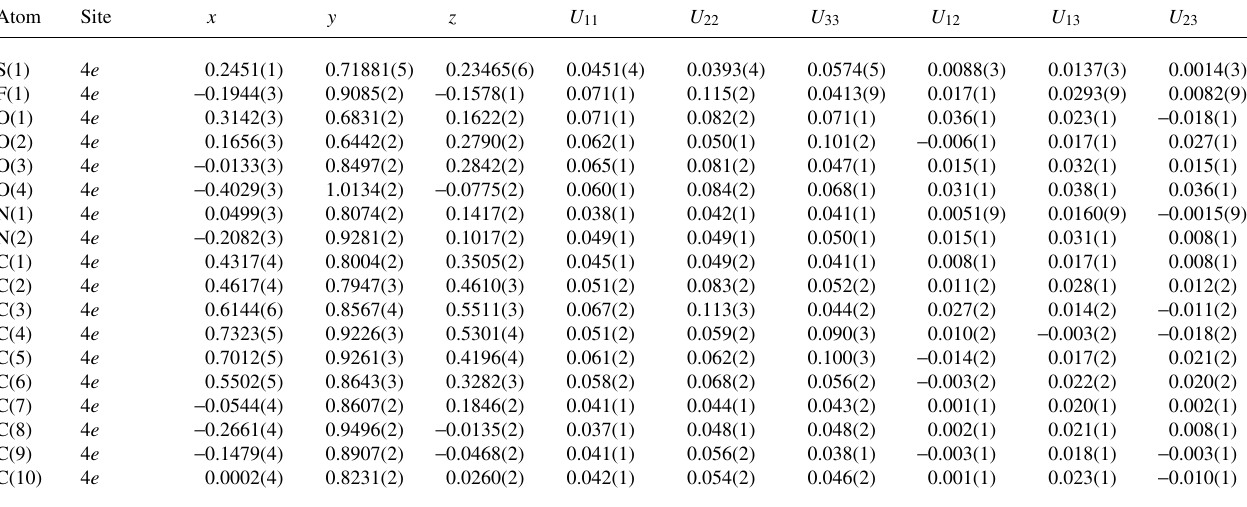
Table 3. Atomic coordinates and displacement parameters (in Å 2 )